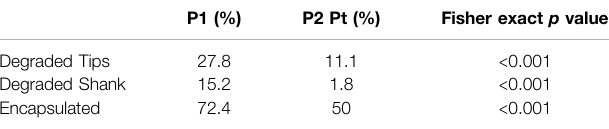
TABLE 3 | Differences observed between patients with different length of implant (980 days for P1 and 182 days for P2) on material degradation and encapsulation for electrically connected platinum recording electrode